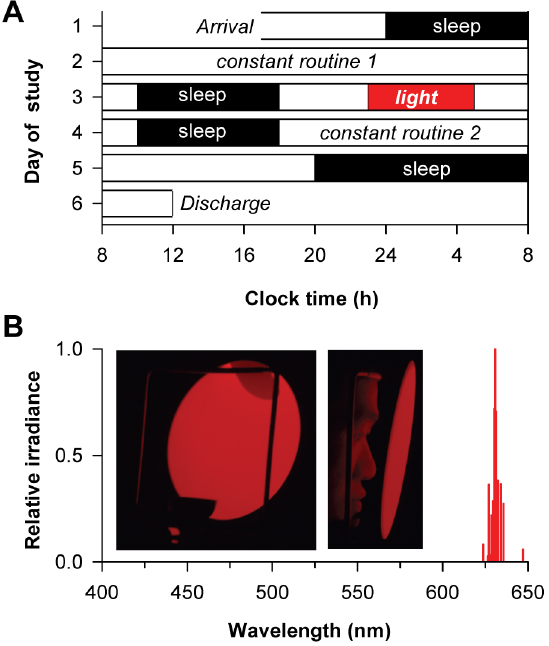
Figure 1. Protocol for assessing circadian phase shift responses and melatonin suppression. ( A ) Subjects took part in a 6-day laboratory study. Circadian rhythms were assessed using constant routine (CR) procedures before and after an experimental light exposure session. During the CR procedure, subjects were exposed to , 5 lux of ambient light. During the light exposure session, subjects were exposed to 6 h of continuous red light (631 nm, 13 log photons cm 2 2 s 2 1 ), intermittent red light and darkness ( , 1 min on, 1 min off), or bright polychromatic white light (2,500 lux; 4000K) starting 1 h before habitual bedtime. ( B ) The narrow-bandwidth red light stimulus was generated using a light-emitting diode and delivered to subjects’ eyes using a modified Ganzfeld dome. The spectral emission of the LED stimulus is shown.